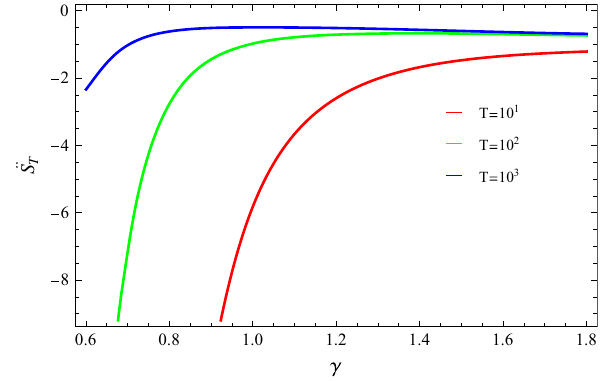
Fig. 5 Plot of ¨ S T versus γ when (cid:2) = constant